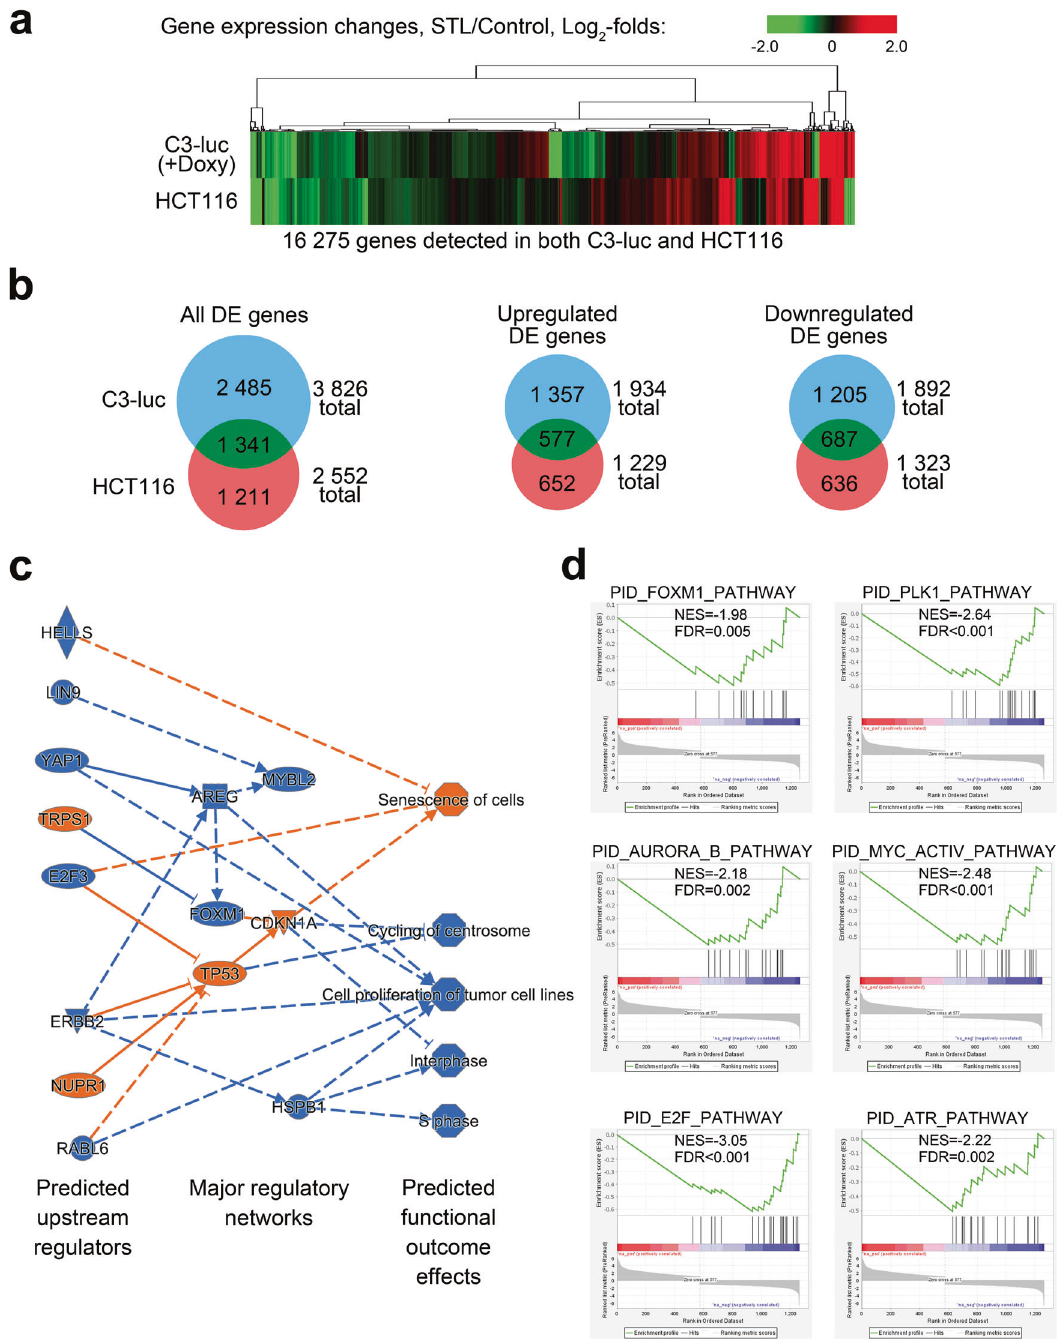
Fig. 6 STL-induced transcriptome changes suggest strong antitumor effect mediated through FOXM1-p21 – p53 regulatory networks. a Heatmap representation of the STL effect on global gene expression changes. HCT116 and doxycycline-stimulated C3-luc cells were treated with 50 μ M STL for 24 h. RNA samples obtained from treated cells were subjected to RNA-seq, non-protein-coding genes were excluded from analysis. Data represent the average of two biological replicates for each condition. b Venn diagrams representing the numbers of DE genes (all, up- or downregulated) in HCT116 and C3-luc cells. Only genes with signi fi cant expression changes (2-fold or higher change, FDR < 0.1) were analyzed. c Ingenuity-predicted regulatory network facilitating STL treatment effects in C3-luc cells based on “ STL signature ” changes. d Results of GSEA performed for “ STL signature ” genes in C3-luc